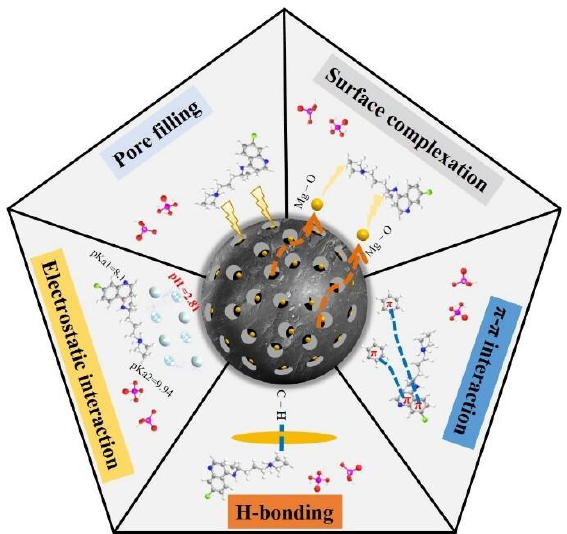
Figure 7. Schematic diagram of adsorption mechanism of CQP adsorption by Fe/Mg-RSB.